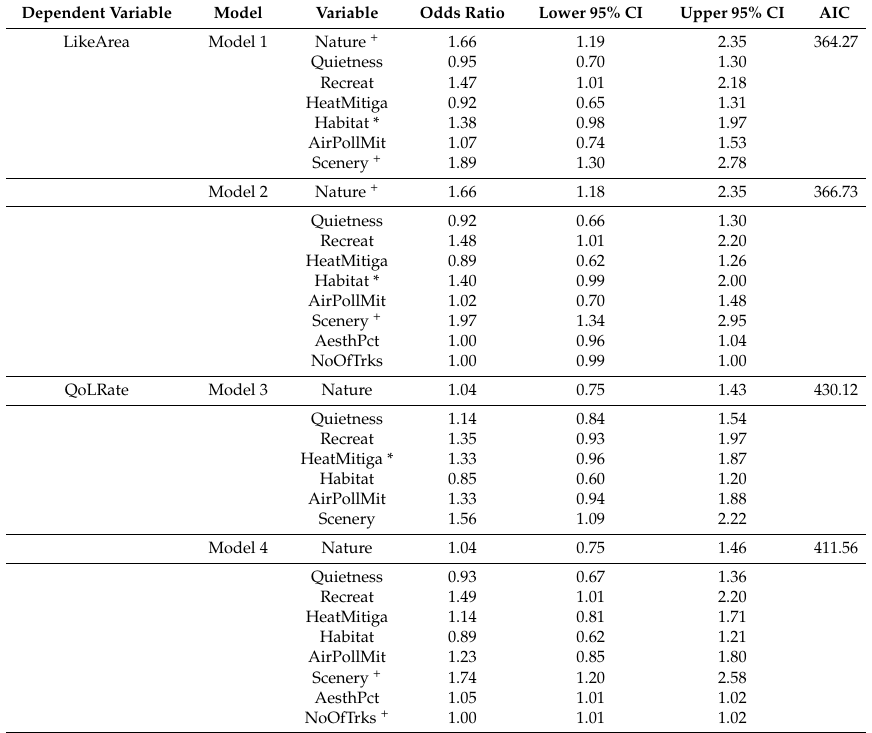
Table 4. Results of the ordinal logistic